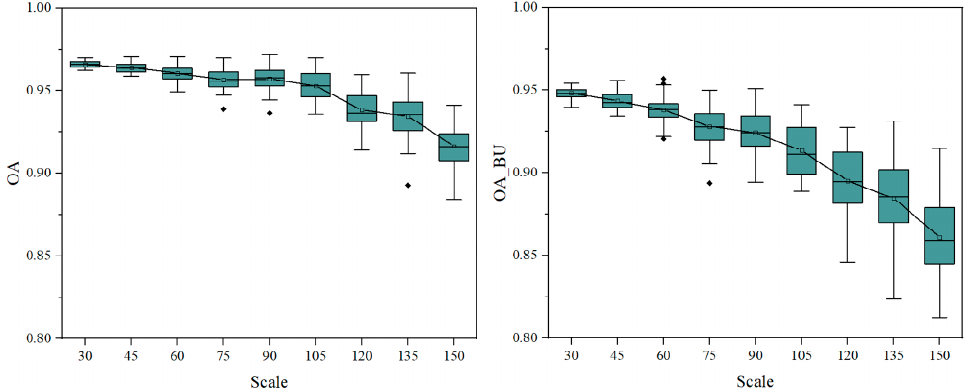
Figure 7. Accuracy boxplots from scale 30 to 150. The left picture shows the change in OA , and the right picture shows the change in OA (cid:3003)(cid:3022) .